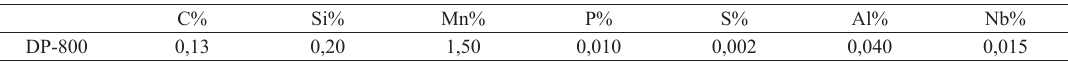
Table 1. Chemical composition of dual phase-DP800